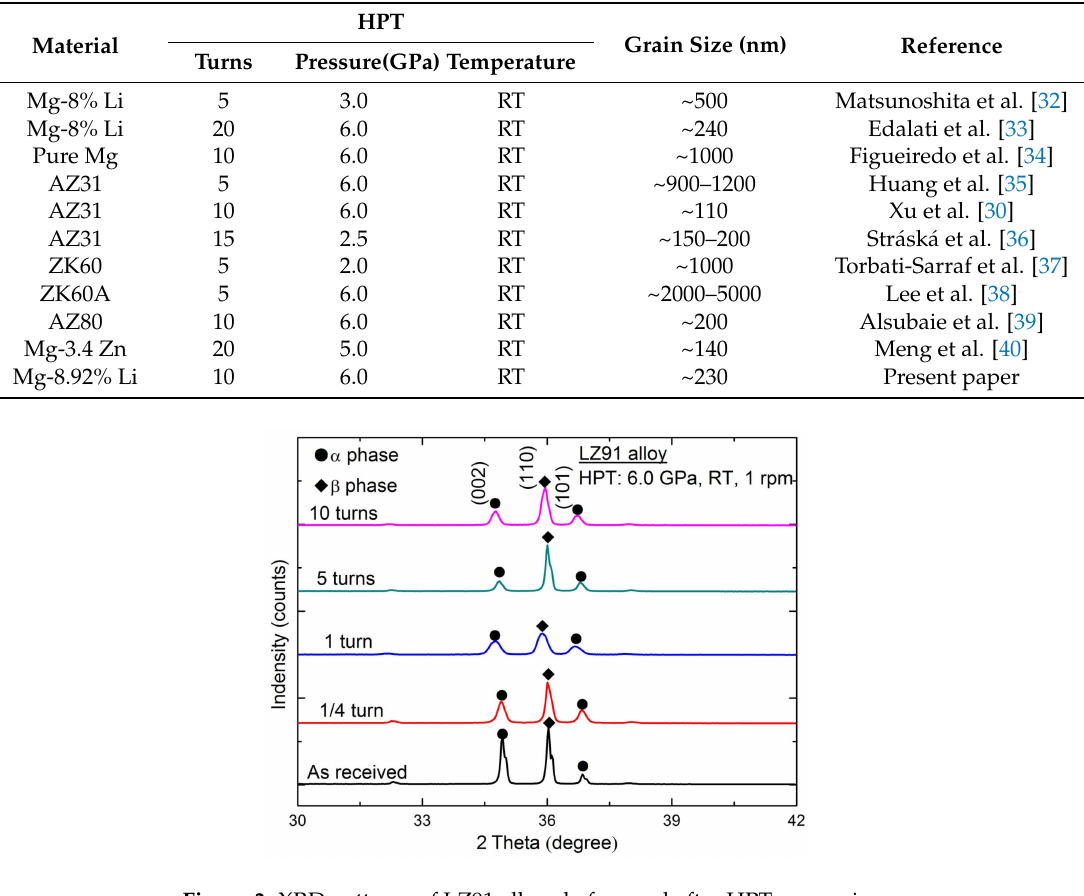
Figure 3. XRD patterns of LZ91 alloys before and after HPT